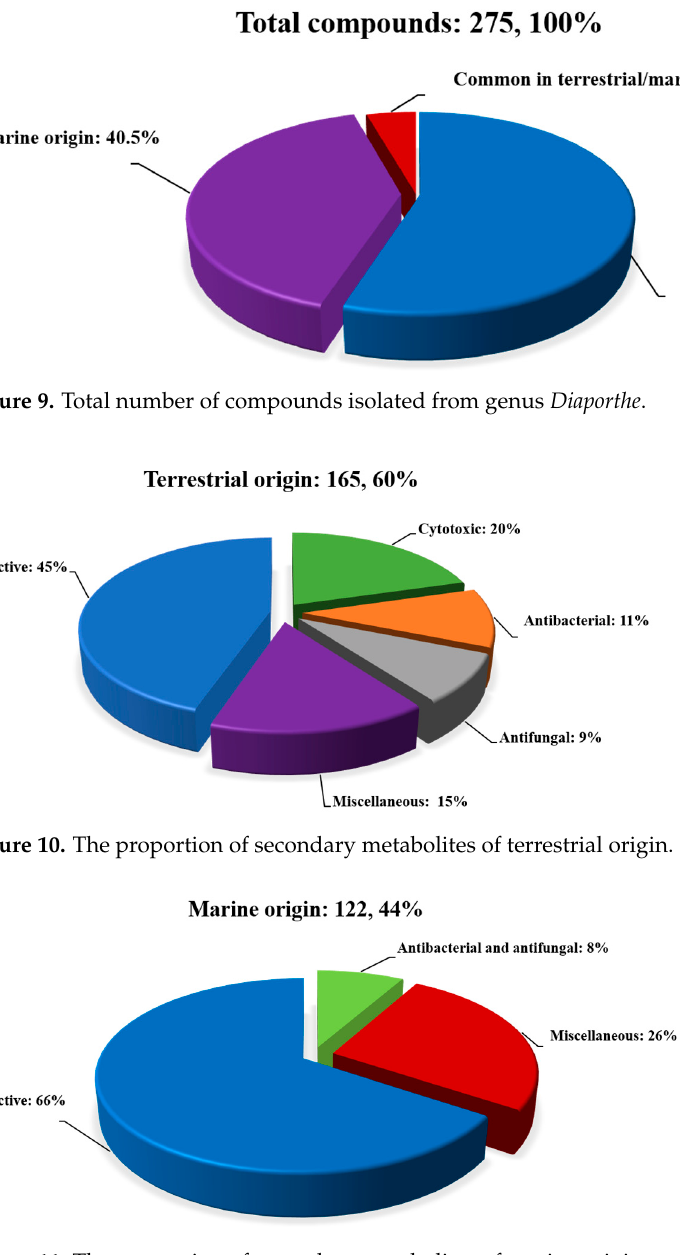
Figure 11. The proportion of secondary metabolites of marine origin.